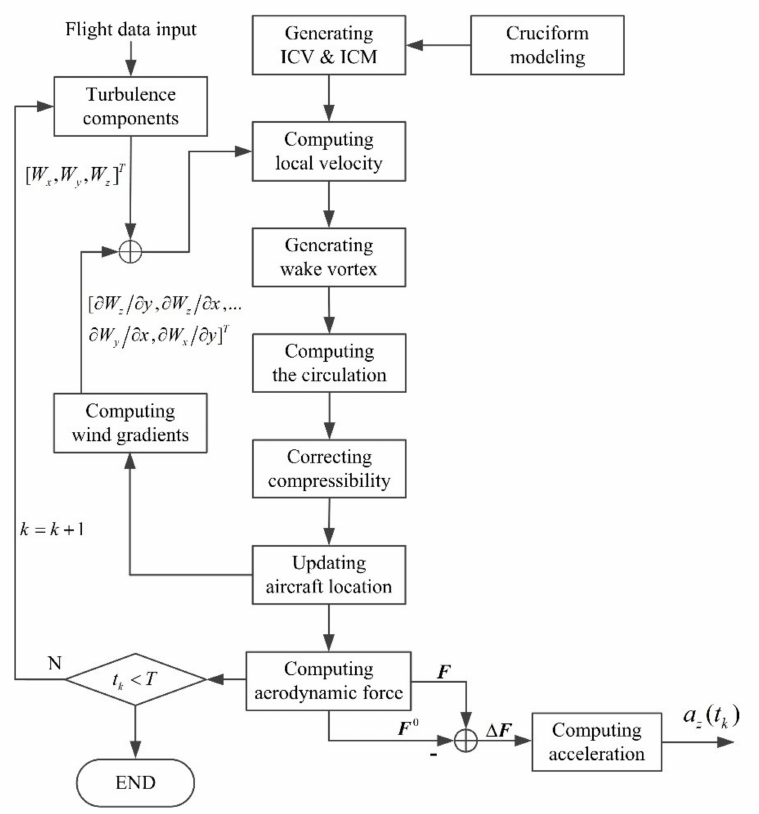
Figure 5. The flowchart of the proposed algorithm.